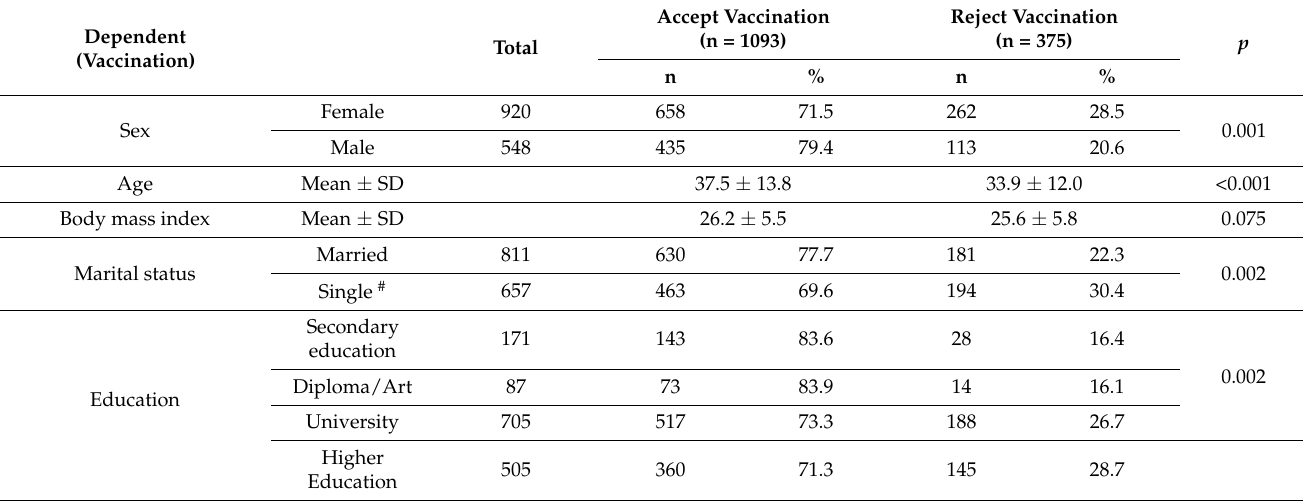
Table 2. Comparison of different characteristics among vaccinated and non-vaccinated